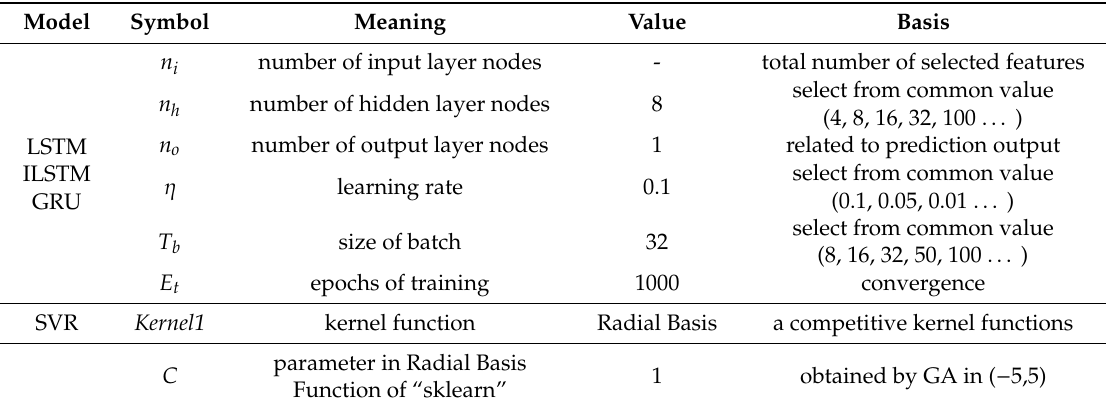
Table 5. Parameter details of deep learning models.